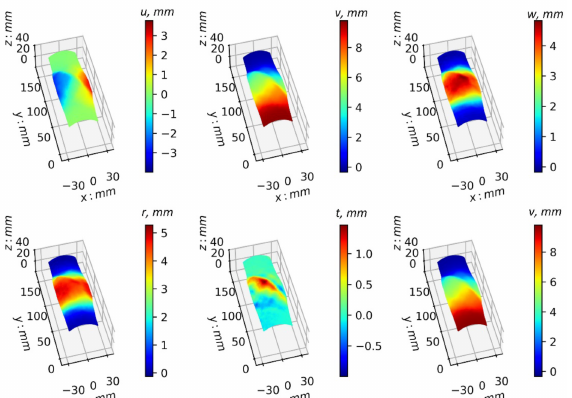
Figure 3. Incremental displacement fields of test 092903b between an axial strain of 3.0% and 9.0% (post-peak of the stress–strain curve). The first row from left to right are displacements along horizon- tal ( u ), vertical ( v ), and out-of-plane ( w ) directions. The second row describes the same displacement field, but decomposed into radial ( r ), tangential ( t ), and axial ( v ) directions in cylindrical coordinates.